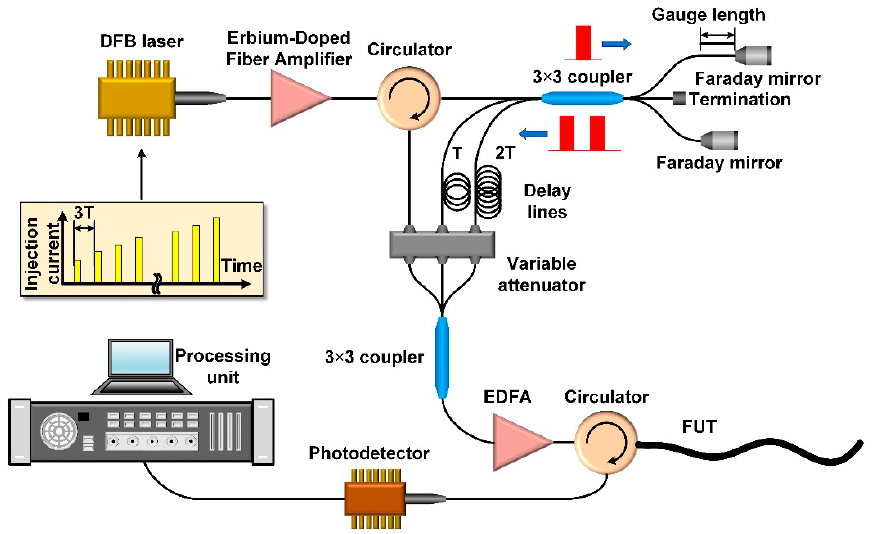
Figure 1. The principal scheme of the proposed DAS. Three pairs of dual-pulses with a phase shift are formed in an unbalanced MI, then, they are appropriately delayed and sequentially enter the FUT. The backscattered light is demodulated in the processing unit.